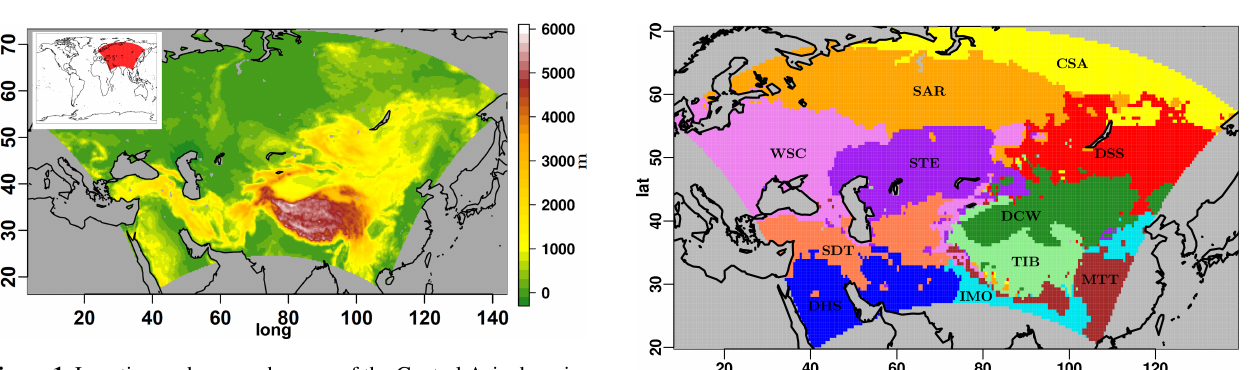
Figure 1. Location and orography map of the Central Asia domain, at a spatial resolution of 0.22 ◦ . Orographic data are derived from the Global Land One kilometre Base Elevation (GLOBE; Hastings et al., 1999) data set.